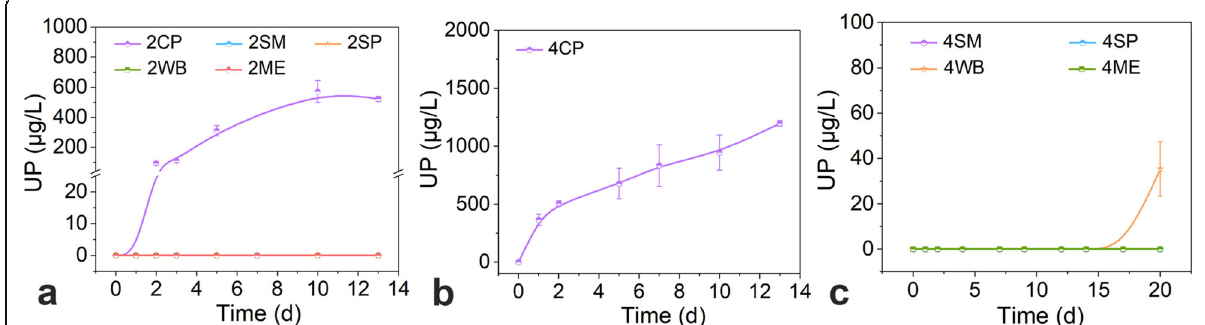
Fig. 2 Comparison of UP producing ability between CP and plant biomass by S. coelicolor CGMCC 4.7172. a The UP concentrations in the 2CP, 2SM, 2SP, 2WB and 2ME media, respectively, during the fermentation process of 13 d. b The UP concentrations in the MM media supplemented with 4 % ( w/v ) CP (4CP media). c The UP yields in 4SM, 4SP, 4WB, and 4ME media, respectively, during the fermentation period of 20 d